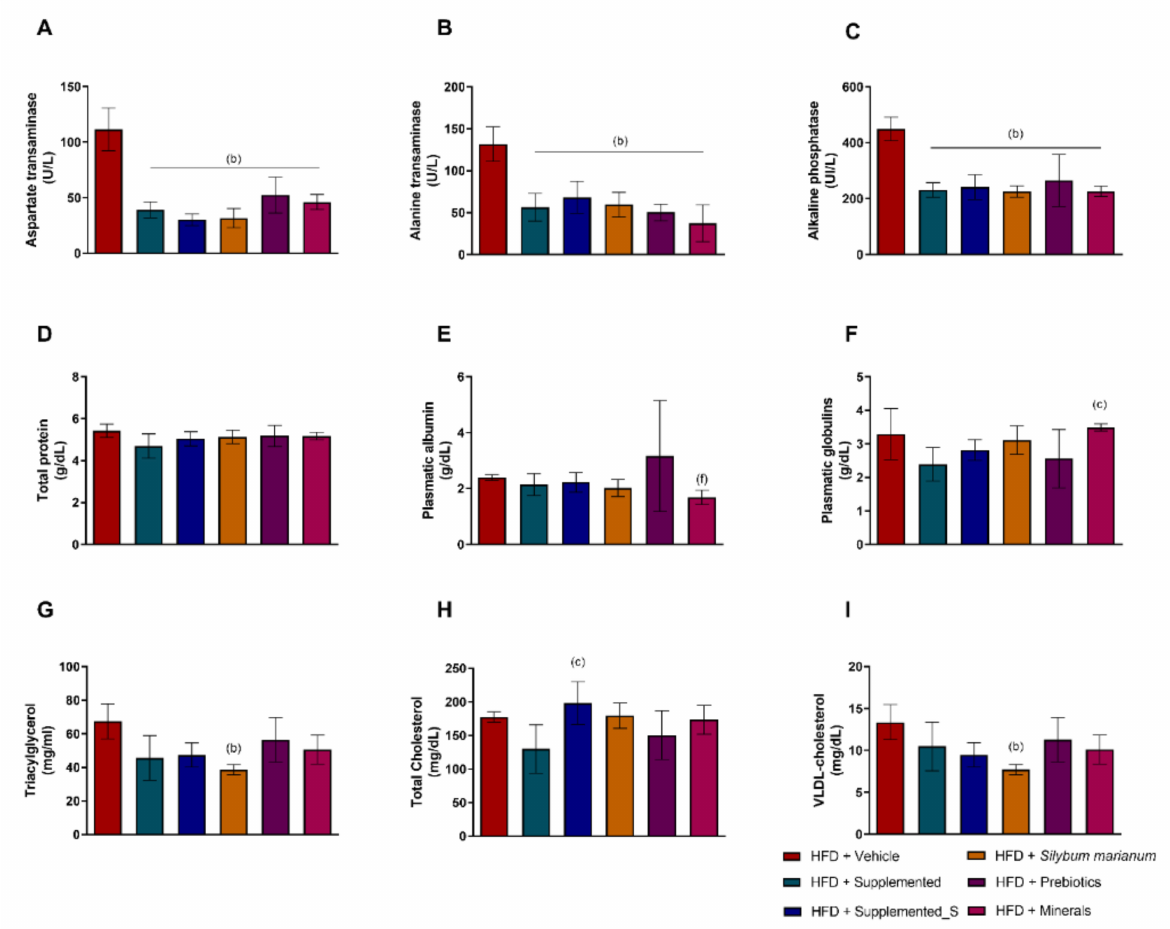
Figure 3. Plasmatic levels of ( A ) ALT: aspartate transaminase; ( B ) AST: alanine transaminase; ( C ) ALP: alkaline phosphatase; ( D ) total plasmatic protein; ( E ) plasmatic albumin; ( F ) plasmatic globulins; ( G ) TAG: triacylglycerol; ( H ) total cholesterol, and ( I ) VLDL-cholesterol. Significant p < 0.05 in one-way ANOVA followed by Tukey’s post-hoc test (n = 3–8 per group): (b) versus HFD + Vehicle; (c) versus HFD + Supplemented; (f) versus HFD + Prebiotics. HFD = high-fat diet. Values are means ±